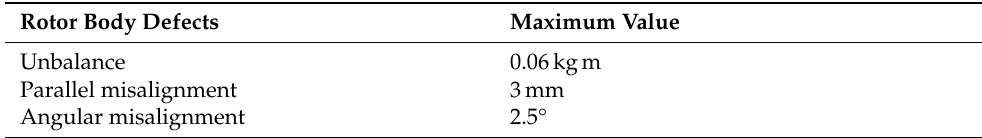
Table 1. Maximum defects allowable with the experimental